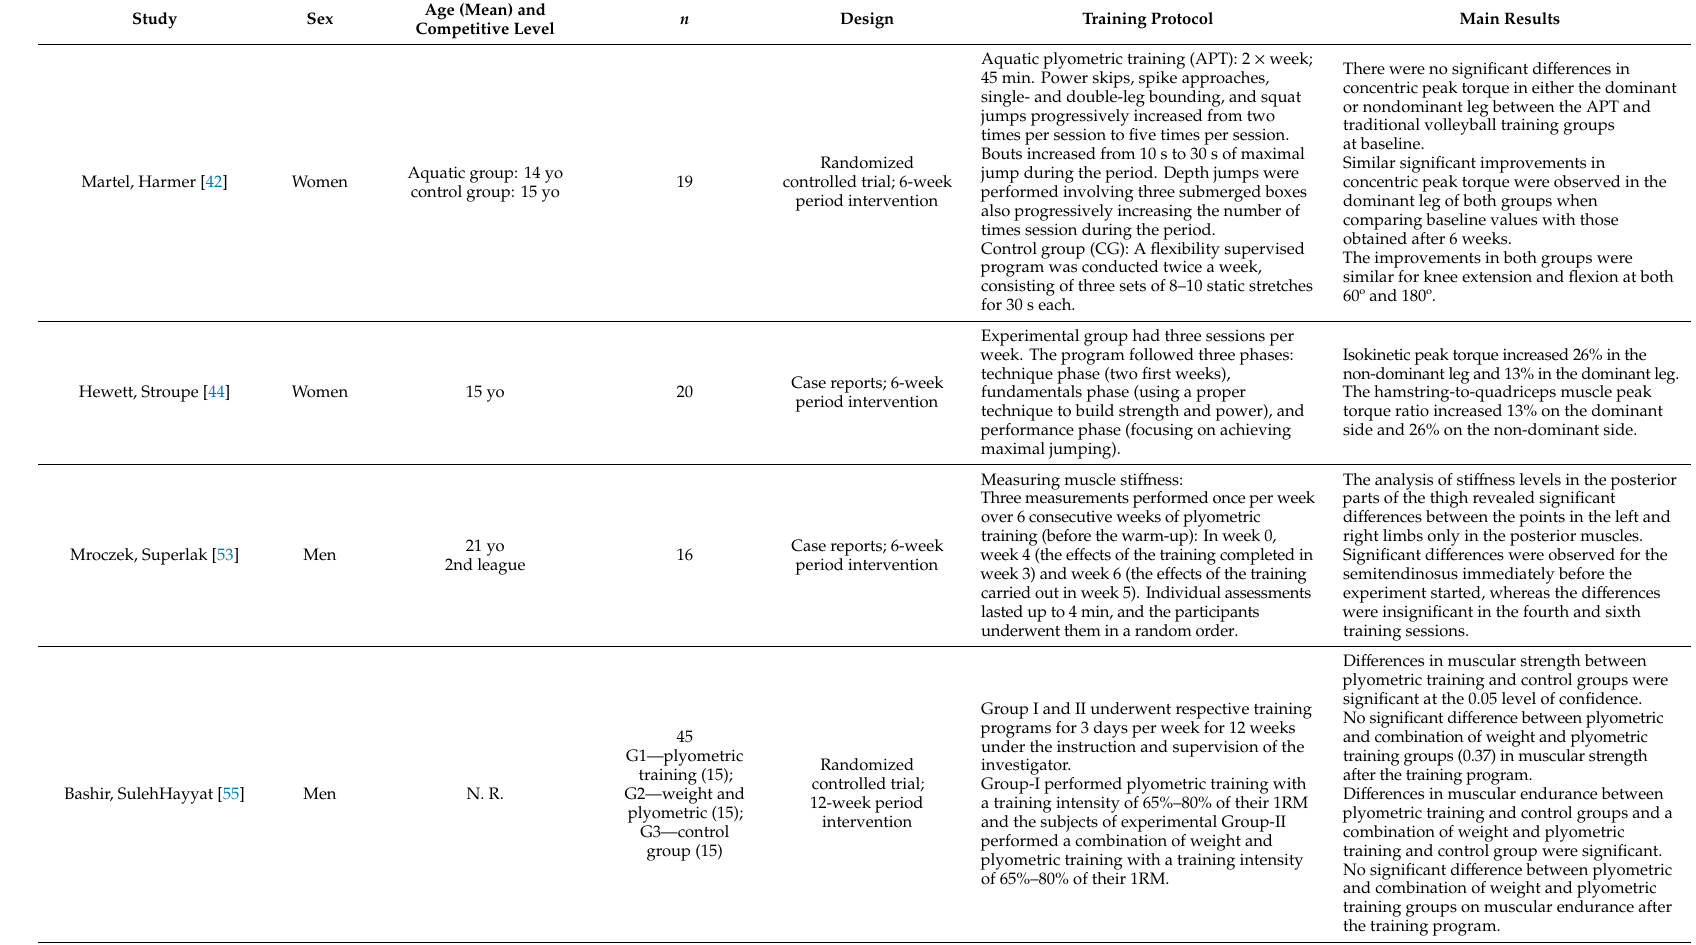
Table 3. Studies that investigated the e ff ects of plyometric training programs on strength